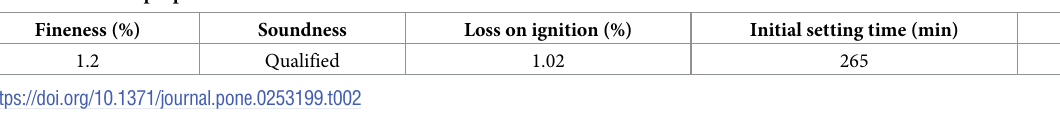
Table 2. Technical properties of